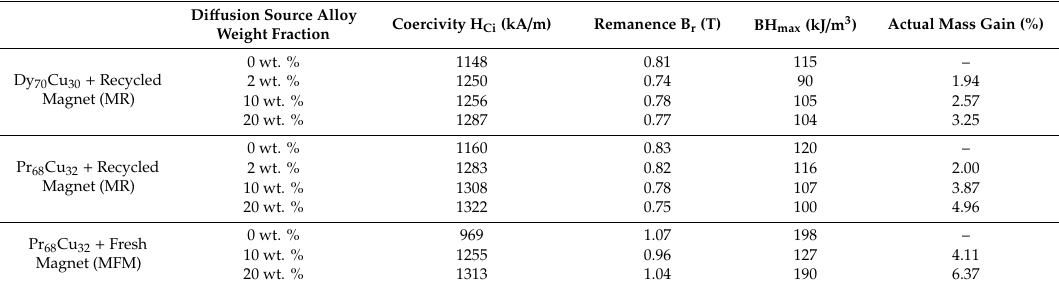
Table 3. Magnetic properties of HDDR Nd-Fe-B bulk magnets after Pr-Cu and Dy-Cu